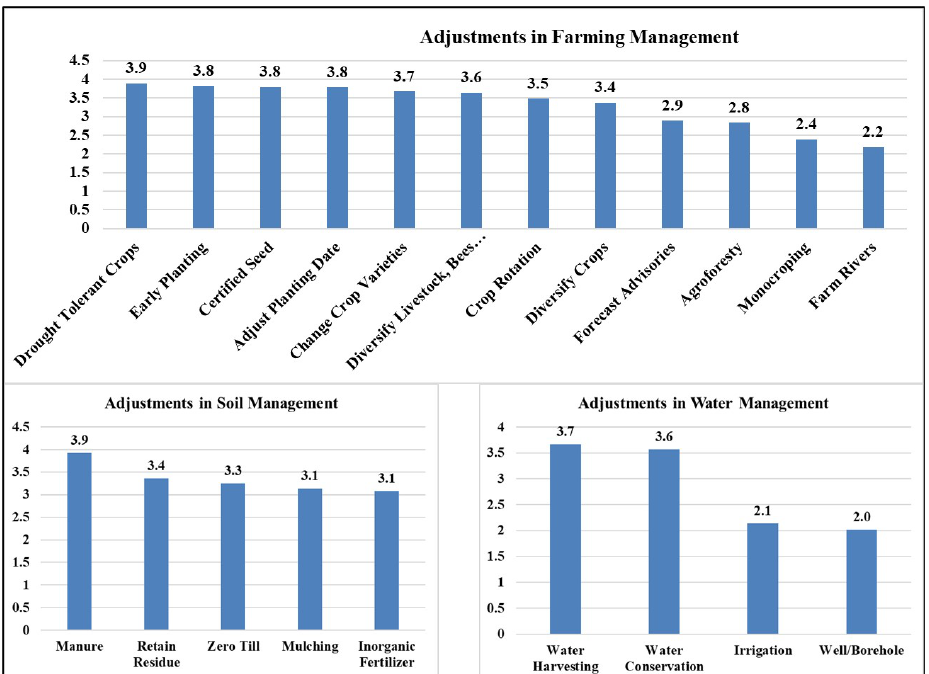
Figure 12. Farmers adaptation strategies for farming, soil and water management.